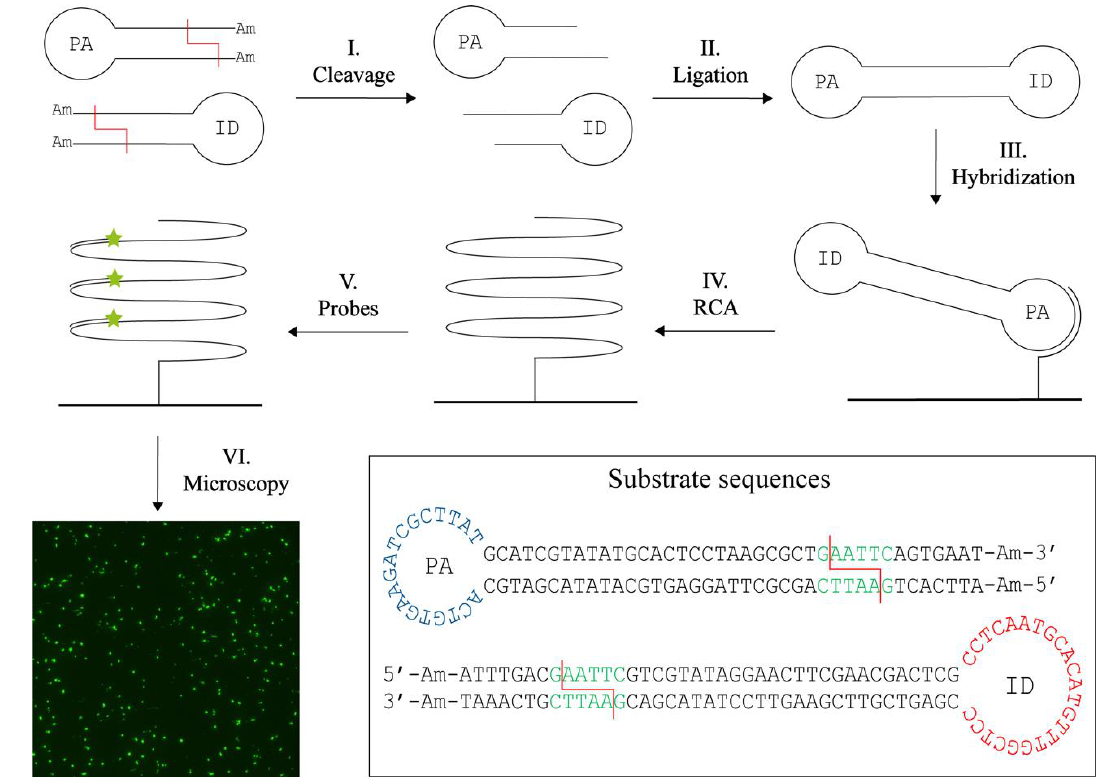
Figure 1. T4 DNA ligase assisted restriction endonuclease (RE) detection. The method uses two DNA hairpin substrates containing a specific restriction site (red line) and amine (Am) blocked ends. The loop of one substrate contains a primer annealing (PA) sequence, while the other contains an identification (ID) sequence. Upon cleavage (I) the blocked ends are removed and the two substrates can hybridize and be ligated with the T4 DNA Ligase (II). Note that only products containing both the PA and ID sequence will be detected. The circular product is hybridized to a surface anchored oligonucleotide (III) that also function as a primer for rolling circle amplification (RCA) (IV). This generates a long tandem repeat product to which fluorescently labelled probes can be annealed (V). The resulting signals can be visualized in a fluorescence microscope (VI). One signal corresponds to two RE digestions and hence provide a quantitative measure. The sequences and folding of the DNA substrates are found in the box with the restriction site (green), here exampled with the restriction site for EcoRI, the cleavage sites (red lines), the PA sequence (blue), the ID sequence (red) and the ends blocked with amines (Am).